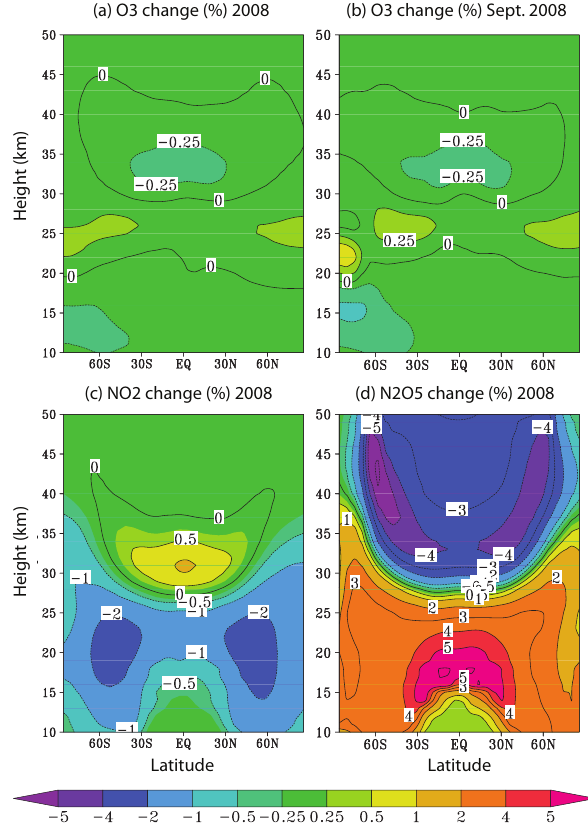
Figure 8. Difference in zonal mean fields (%) for 2008 from the Fig. 8. Difference in zonal mean fields (%) for 2008 from the run of the SLIMCAT 3-D CTM with scaled J N 2 O 5 (run N) minus the run run of the SLIMCAT 3-D CTM with scaled J N with recommended JPL-2011 kinetics (run R) for (a) annual mean O 3 , (b) September mean O 3 , (c) annual mean NO 2 , and (d) annual mean N 2 O 5 . Note irregular contour interval. the run with recommended JPL-2011 kinetics (run R) for (a) an- nual mean O 3 , (b) September mean O 3 , (c) annual mean NO 2 and (d) annual mean N 2 O 5 . Note irregular contour